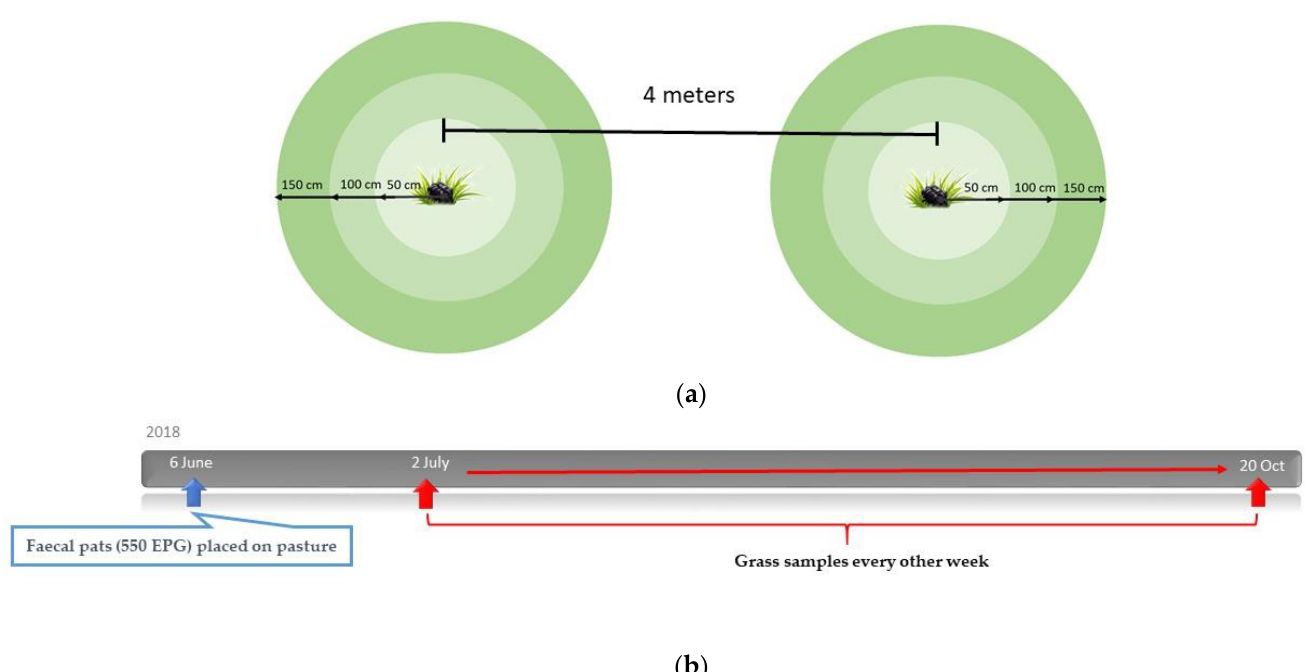
Figure 4. Migration study, 2018 : ( a ) Two faecal pats, each weighing 2 kg, were placed 4 metres apart on the pasture, on 6 June (four weeks prior to the first sampling). Every other week, from the 2 July until the 20 October, pinches of grass were collected at regular intervals of 15 cm along a circular perimeter at three different distances from the centre of each pat: 50 cm, 100 cm and 150 cm. ( b ) A timeline representing an overview of the experimental set-up.